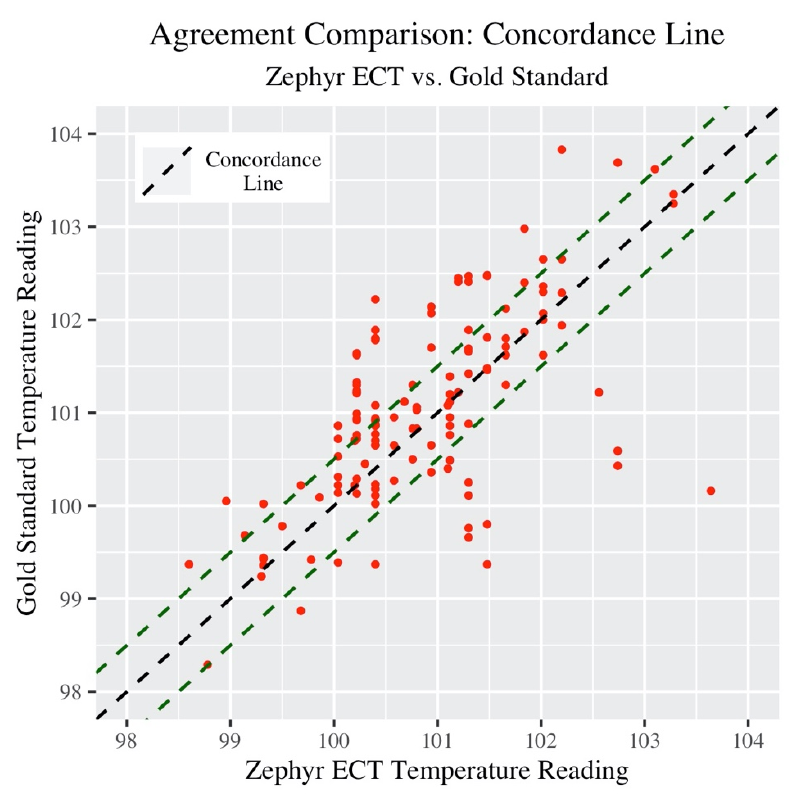
Figure 2. Concordance plot: ECT versus Gold Standard.